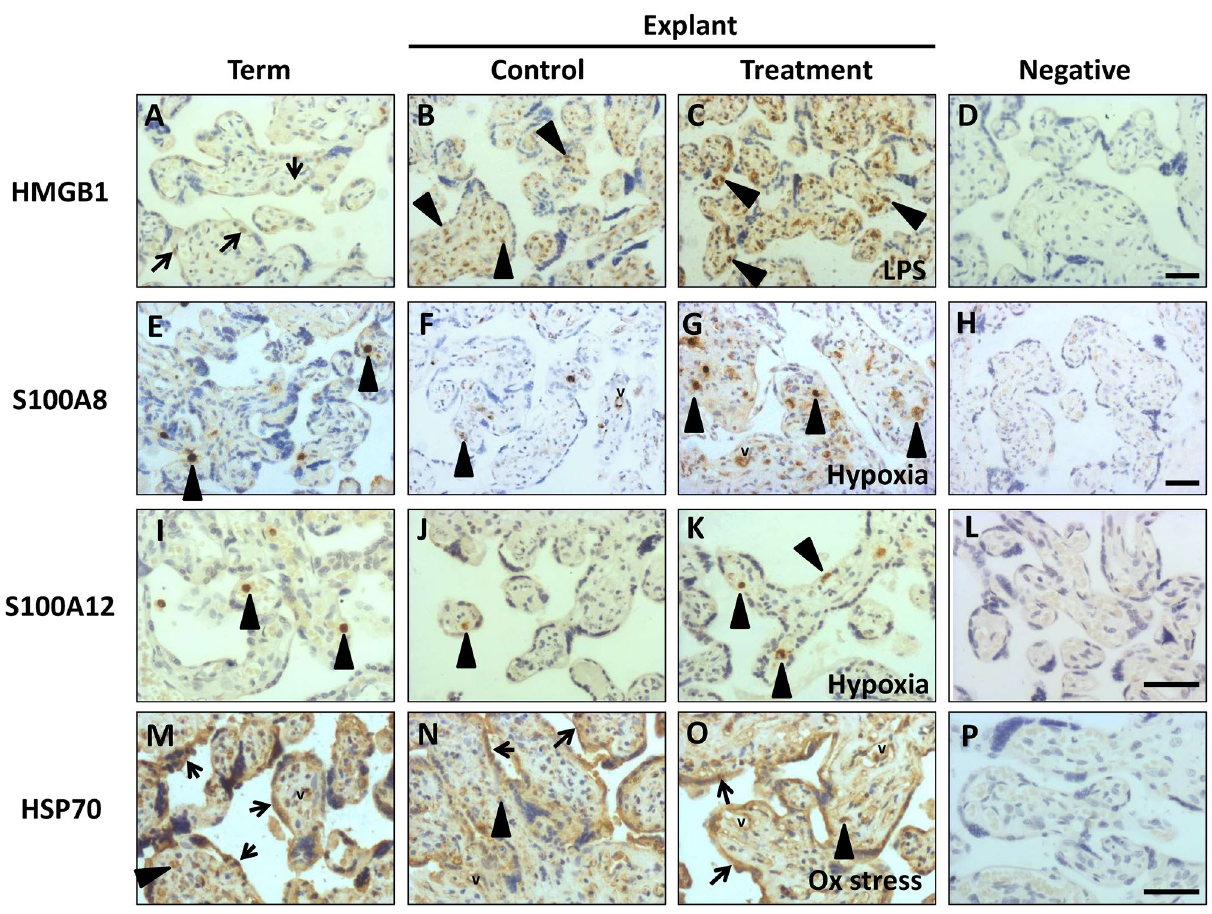
Figure 4. Localisation of DAMPs in term placenta from uncomplicated pregnancies and placental explants cultured under control conditions or exposed to hypoxia (1% O 2 ), oxidative stress (1 mM H 2 O 2 ) or LPS (1 ng/ml) treatment for 72 h. Representative images from three independent experiments are shown. Immunohistochemistry for: ( A – D ) high mobility group box 1(HMGB1), ( E – H ) S100 calcium binding protein A8 (S100A8), ( I – L ) S100 calcium binding protein A12 (S100A12) and ( M – P ) heat shock protein 70 (HSP70). Black arrow heads indicate representative positive stromal cells, black arrows show representative positive trophoblast cells, v = vessels. Magnification × 200. Scale bar marked on negative controls represents 50